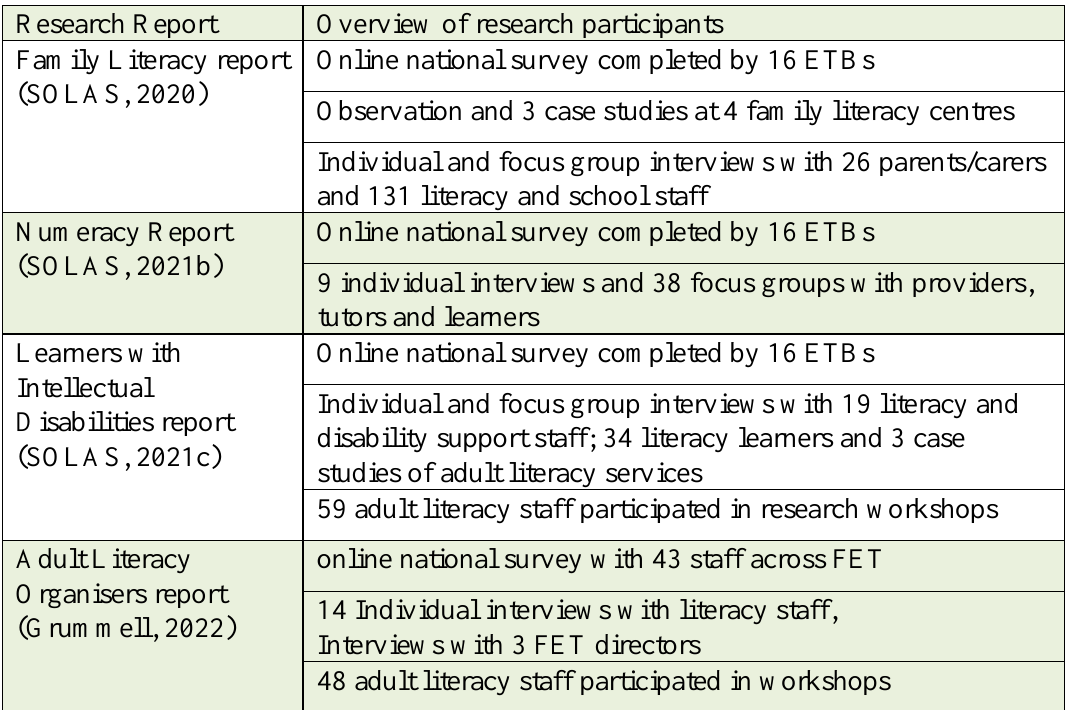
Table 1. Overview of participants in literacy research reports Research